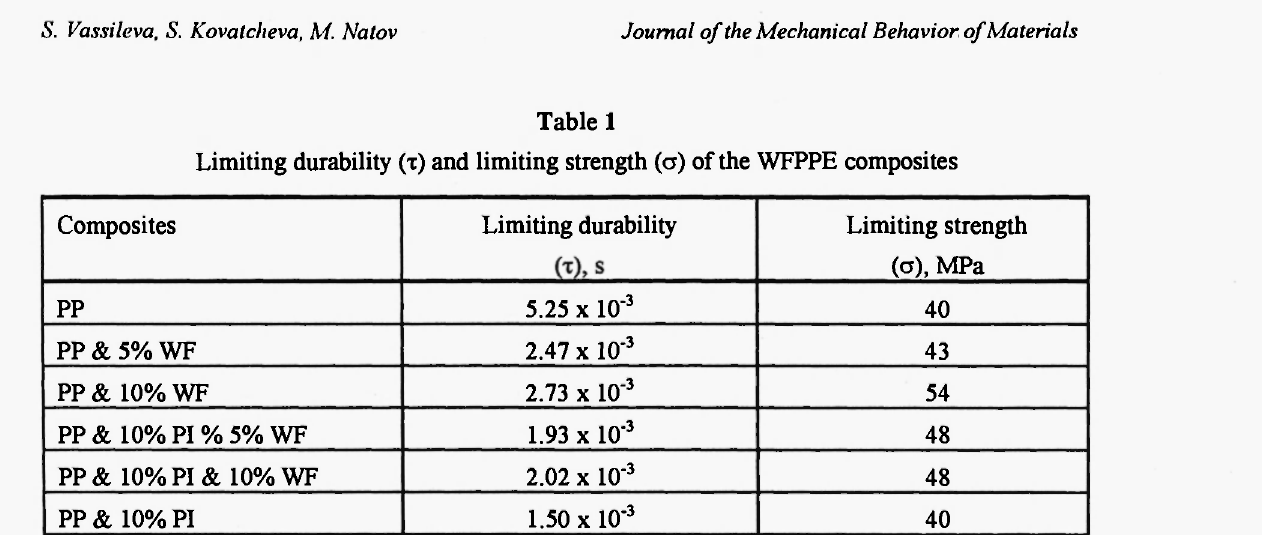
Limiting durability (τ) and limiting strength (σ) of the WFPPE composites